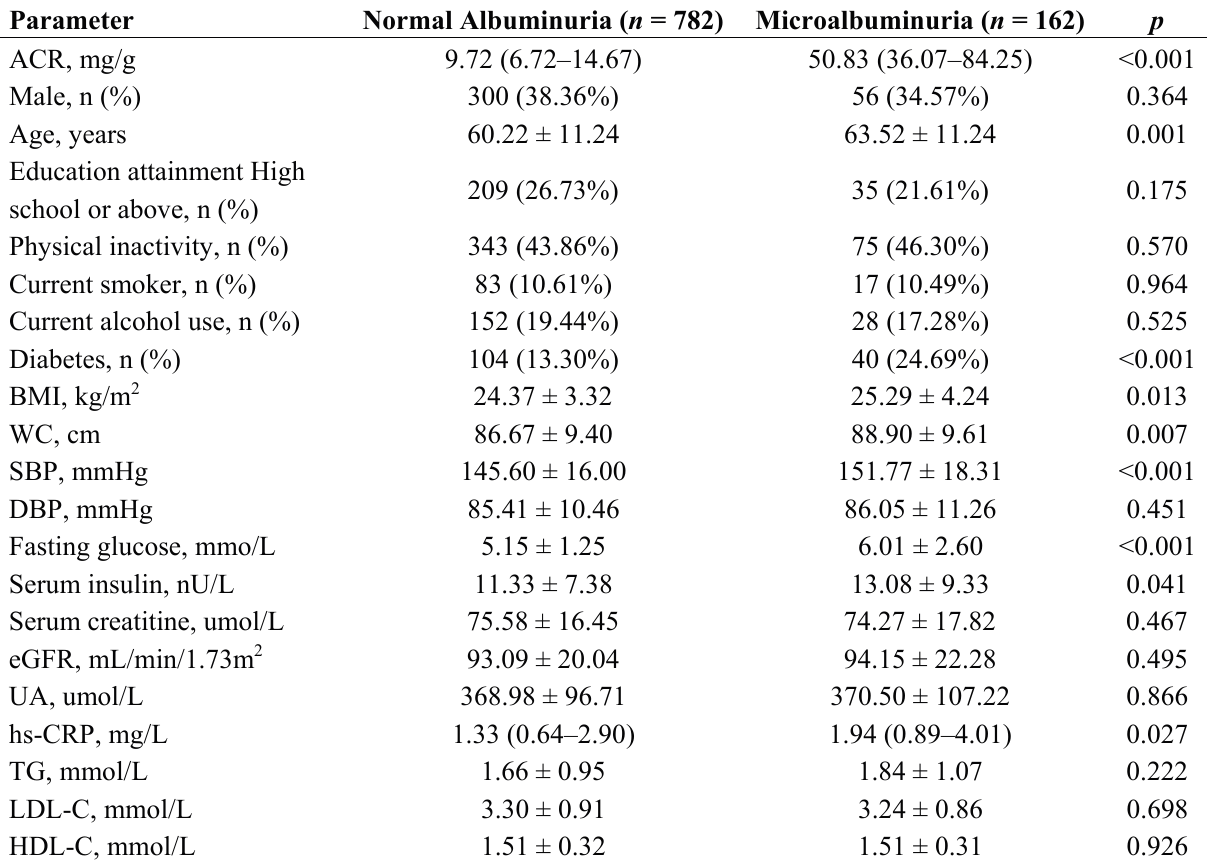
Table 1. The comparative between subjects with normal albuminuria and